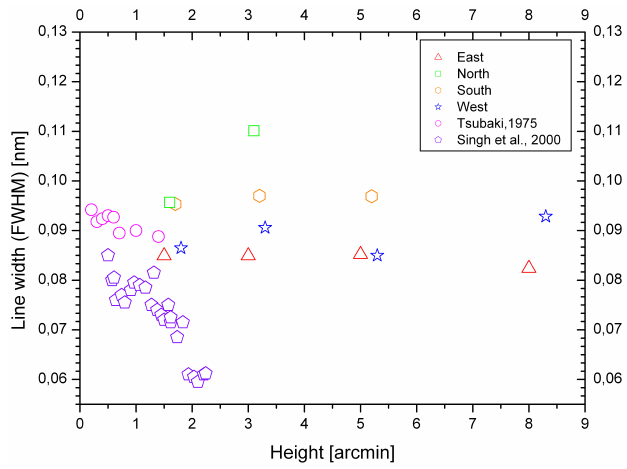
Figure 6 Fig. 6. Variations of the line widths as a function of height above the limb for different directions shown in Fig. 1 of this paper, and above coronal enhancement regions, as reported by Tsubaki (1975) and also, for selected regions, by Singh et al. (2000).